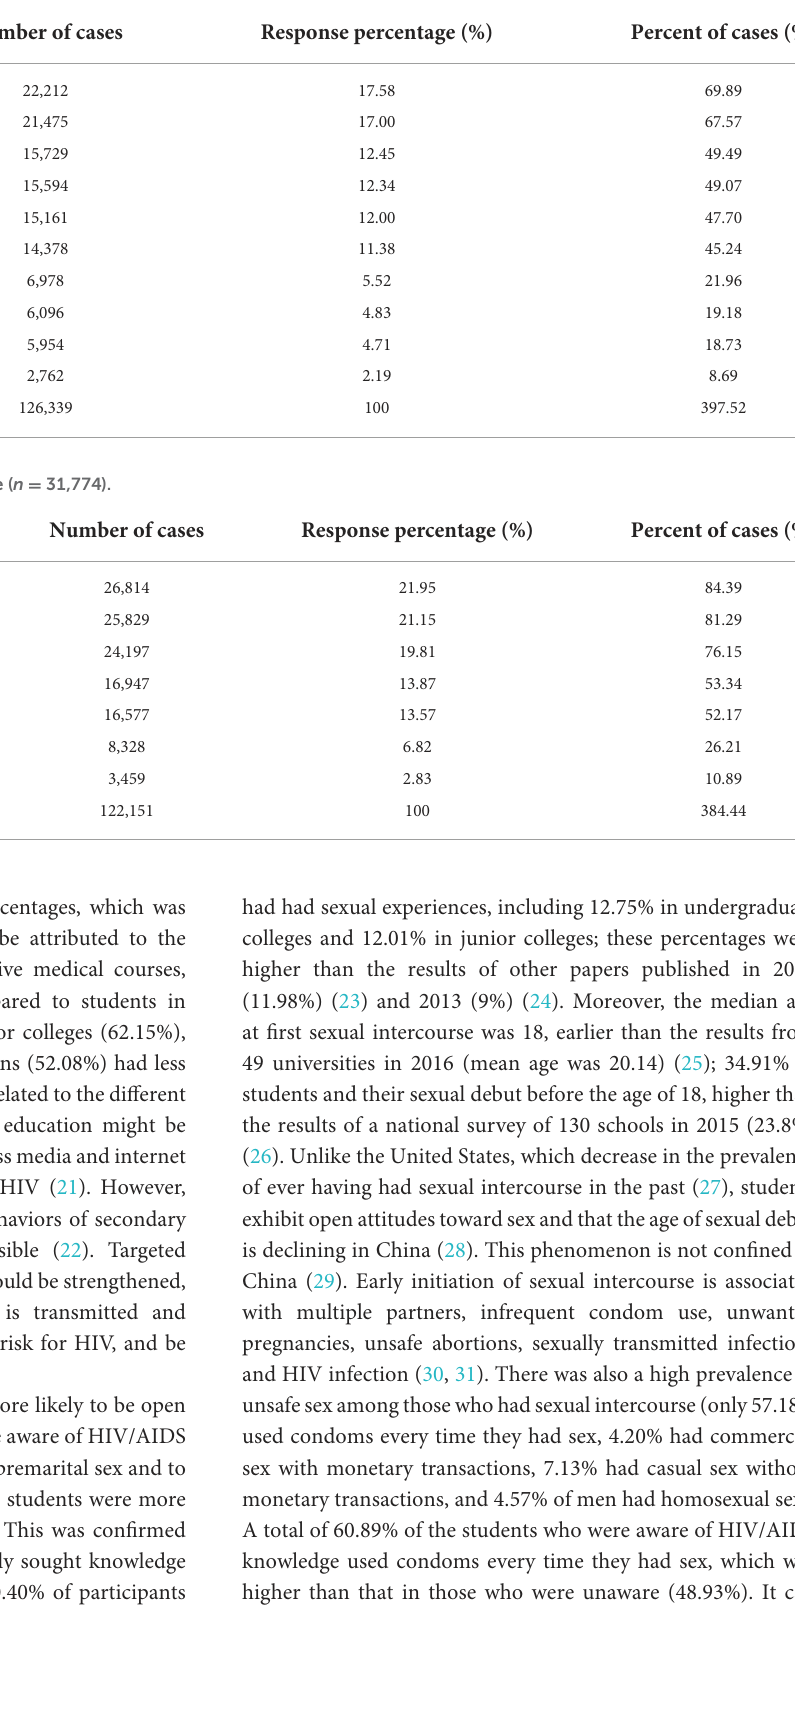
TABLE 11 Main sources of sexual knowledge ( n = 31,782).